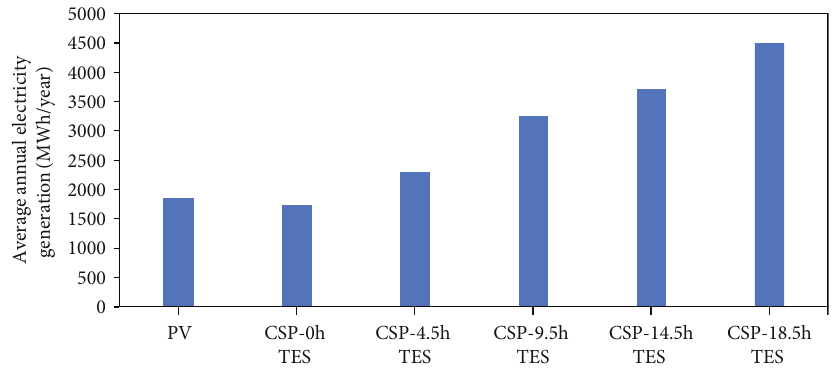
Figure 11: Total annual electrical energy generation from the PV and PT-CSP systems.